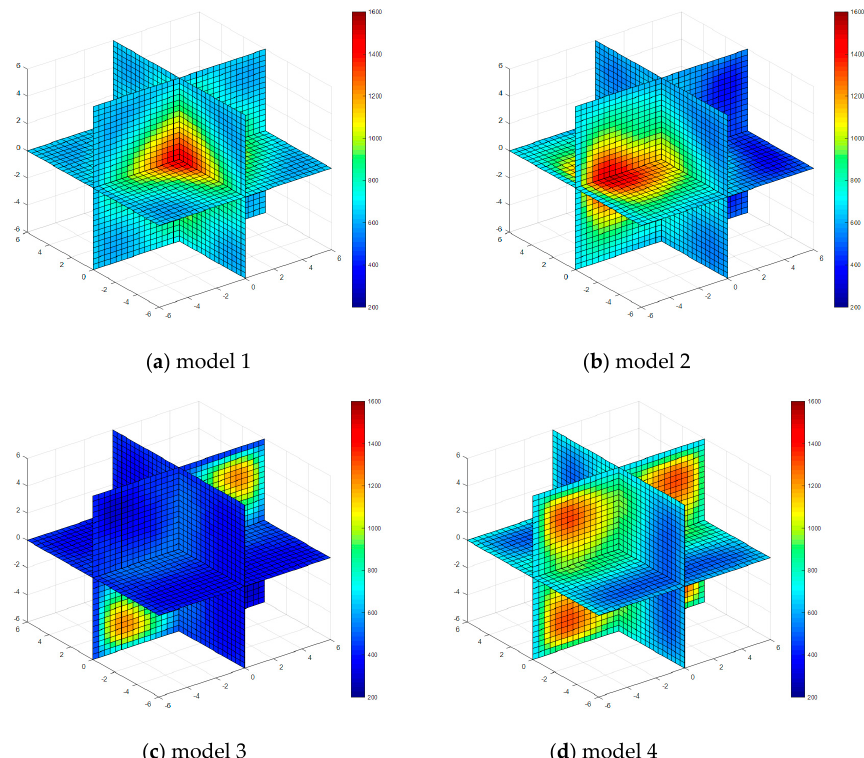
Figure 4. Diagram of reconstructed temperature fields by the least squares method.